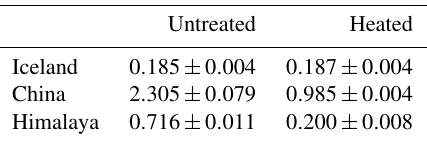
Table 2. Total carbon (%C) of the untreated and heated dust sam- ples. Shown is the average value of the two measurements and 1 standard